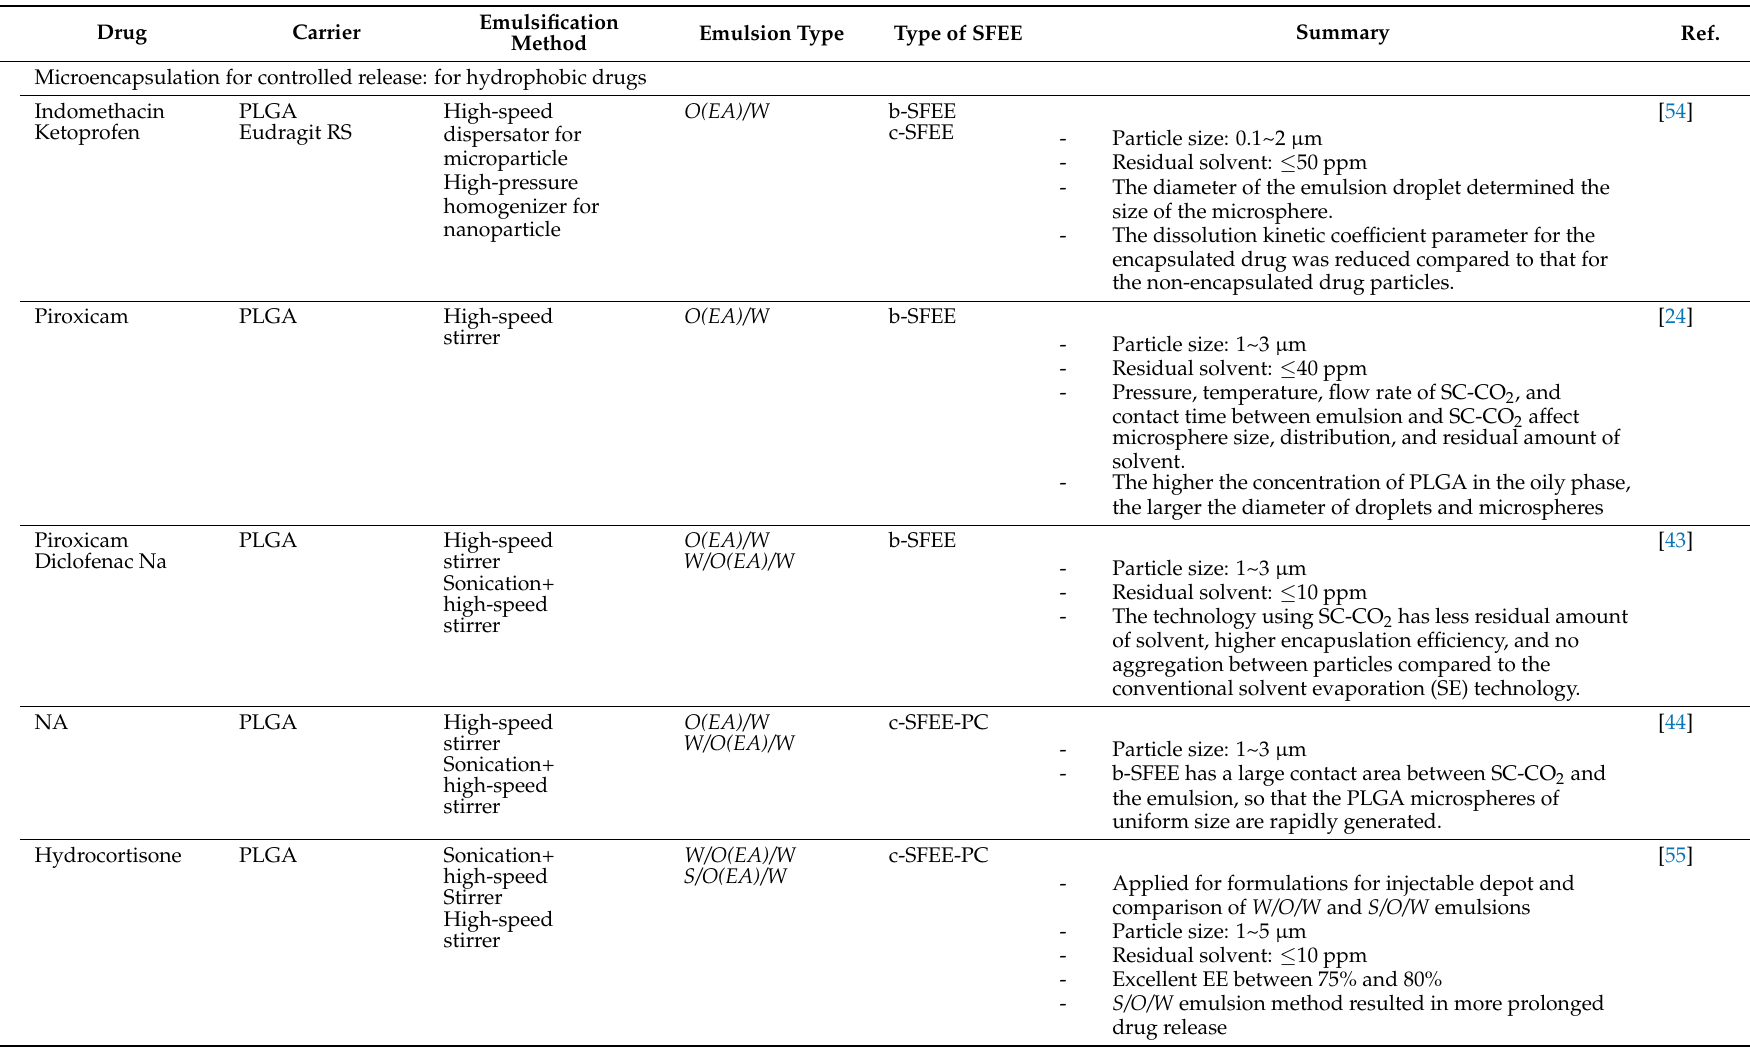
Table 2. Pharmaceutical application cases of SFEE